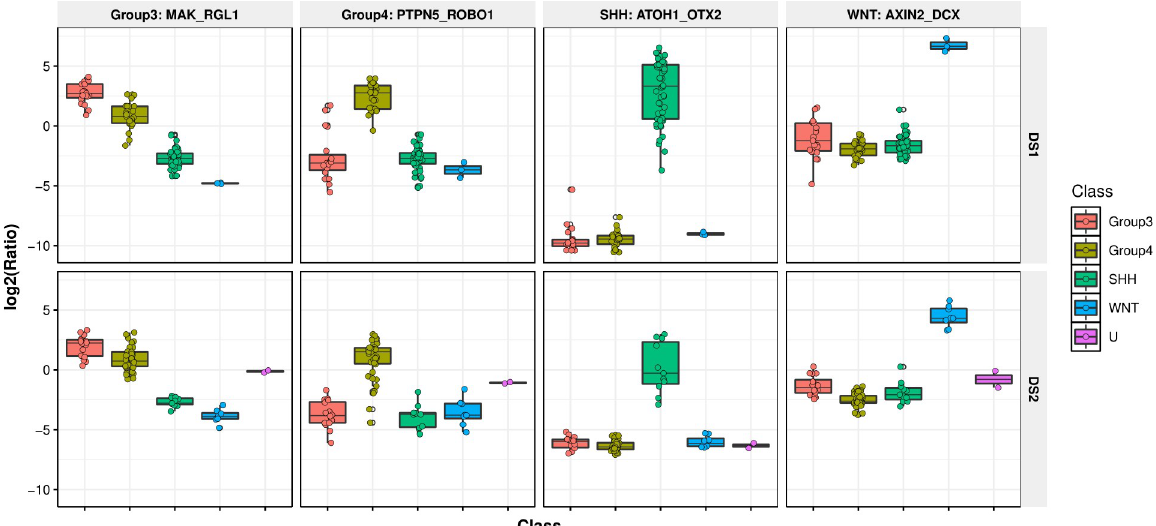
Fig 4. GERs associated with SHH and WNT are more discriminatory compared to Group 3 and Group 4 subtypes. Boxplot of example GERs associated with molecular subtypes across 2 studies. DS1 represents the RNA-seq dataset EGAD00001001899 and DS2 represents the Microarray dataset